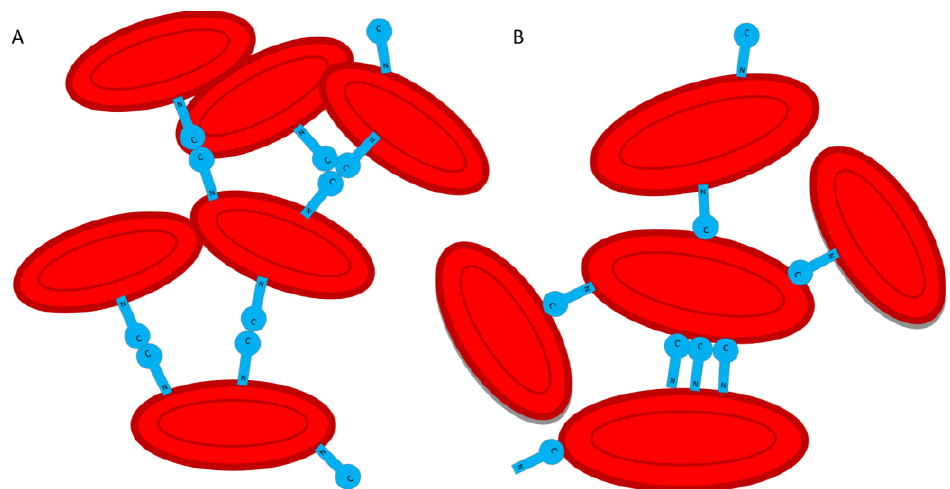
Figure 6. Proposed schemes of erythrocyte agglutination. ( A ) Agglutination can occur due to the binding of the N-terminal region of HlyIILCTD to the surface of erythrocytes and the oligomeriza- tion of the C-terminal region of HlyIILCTD. ( B ) Agglutination can occur because of the binding to the surface of both the N-terminal and C-terminal regions of HlyIILCTD.